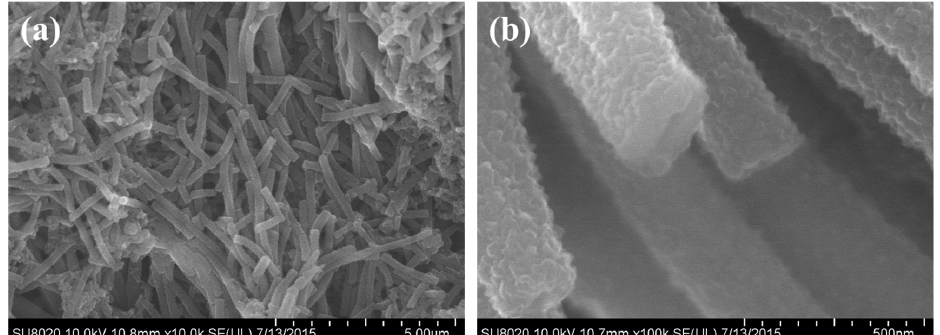
Figure 3. Scanning electron microscopy (SEM) images of the polyaniline (PANI) nanotubes prepared at CA/Ani = 0.5, APS/Ani = 1 with Ani of 2 mmol and ice bath for 24 h. ( a ) the SEM image of PANI with a scale of 5 μ m; ( b ) the SEM image with a scale of 500 nm.